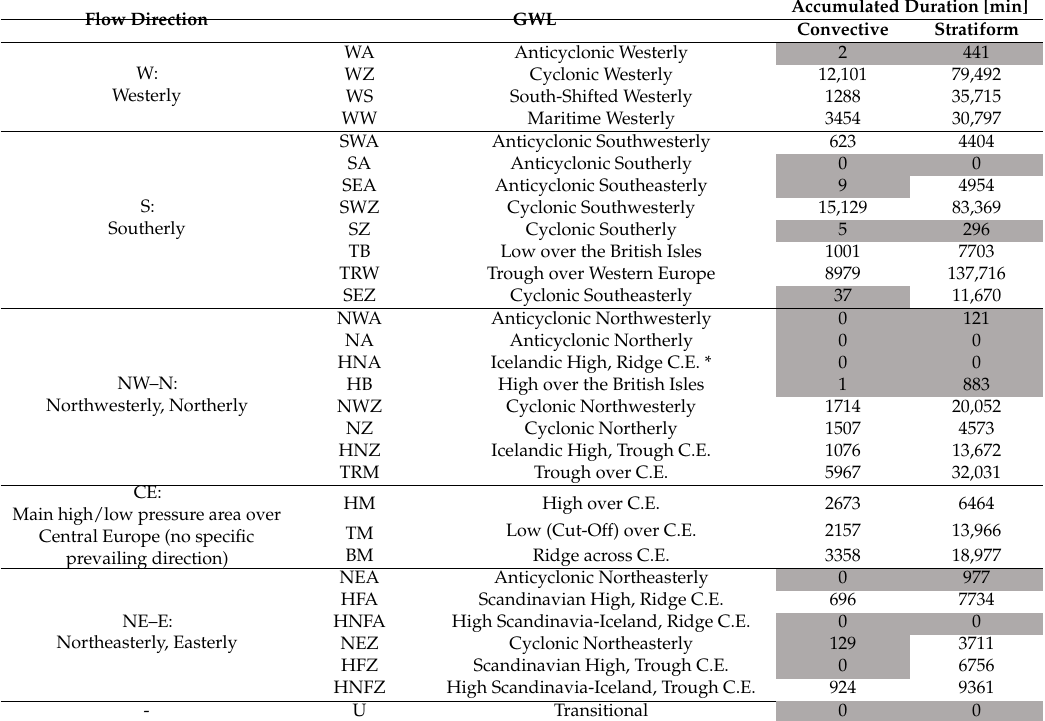
Table 1. General weather patterns (GWLs) according to Hess and Brezowsky [39] and their classification based on the flow direction [50]. This table also includes the accumulated rain duration over all devices for each GWL in both rain types. Gray cells indicate GWLs with small sample sizes, which are not further considered in the